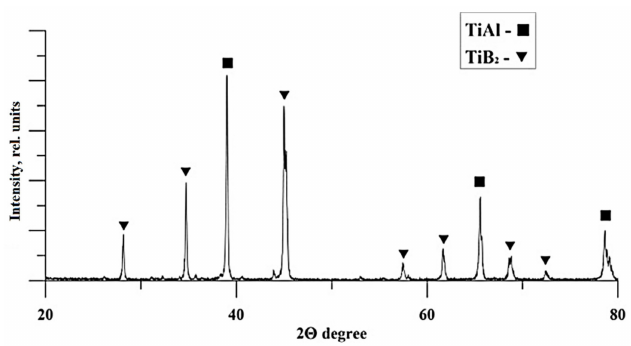
Figure 3. X-ray di ff raction diagram of the MA2.